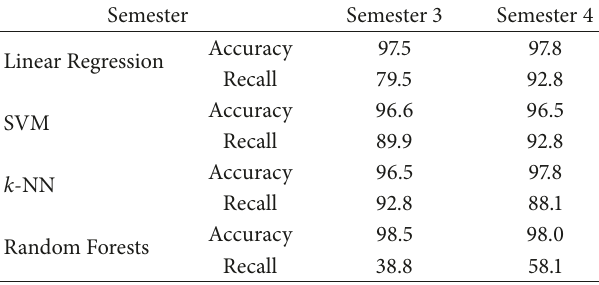
Table 1: Link formation prediction results for the behavioral